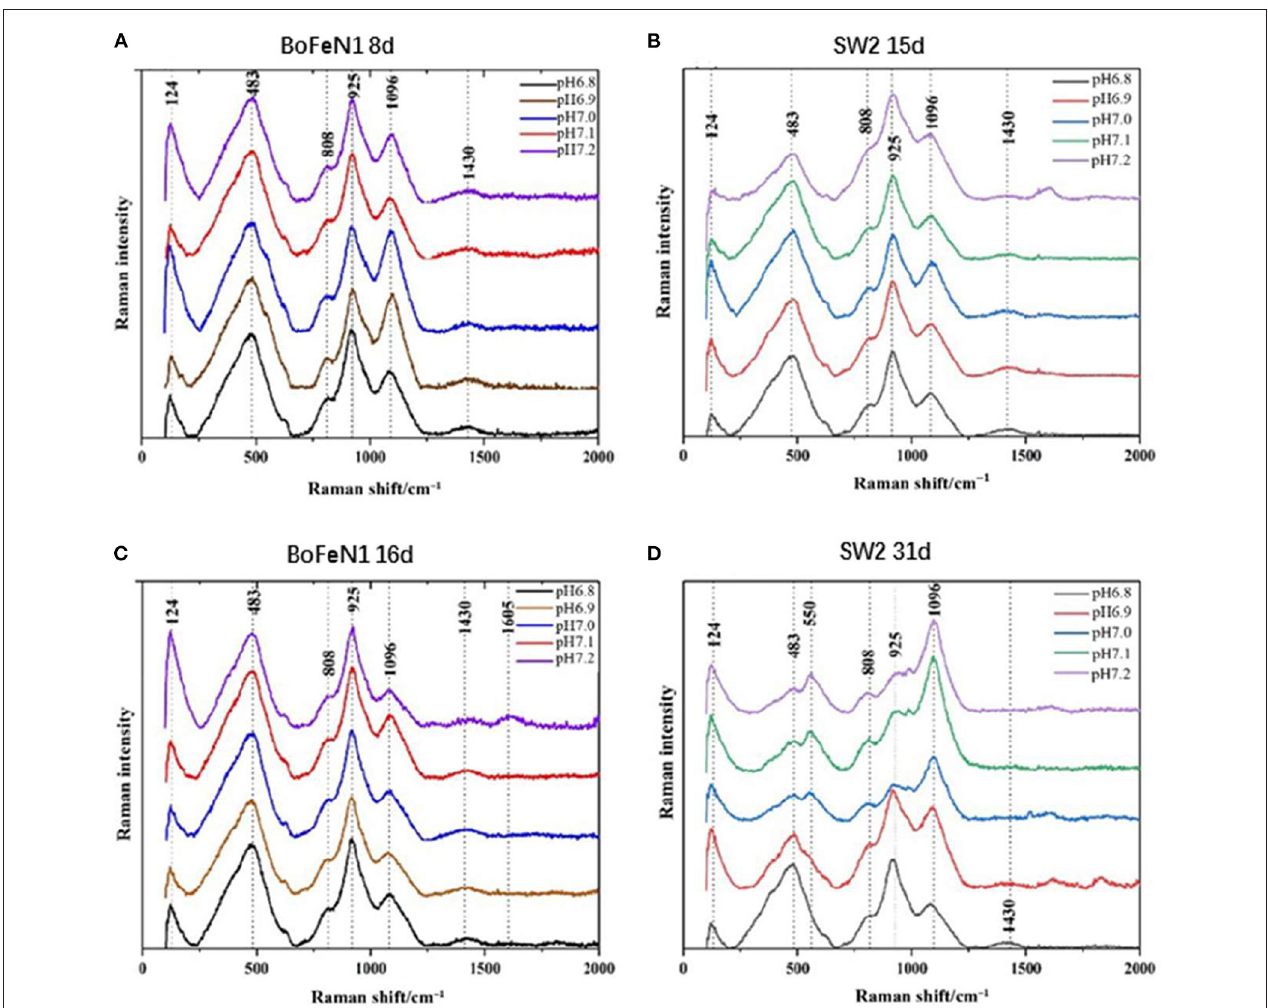
FIGURE 5 | Raman spectra of precipitates collected from (A) 8 d of Acidovorax sp. strain BoFeN1; (B) 15 d of Rhodobacter ferrooxidans strain SW2; (C) 16 d of Acidovorax sp. strain BoFeN1; and (D) 31 d of Rhodobacter ferrooxidans strain SW2.